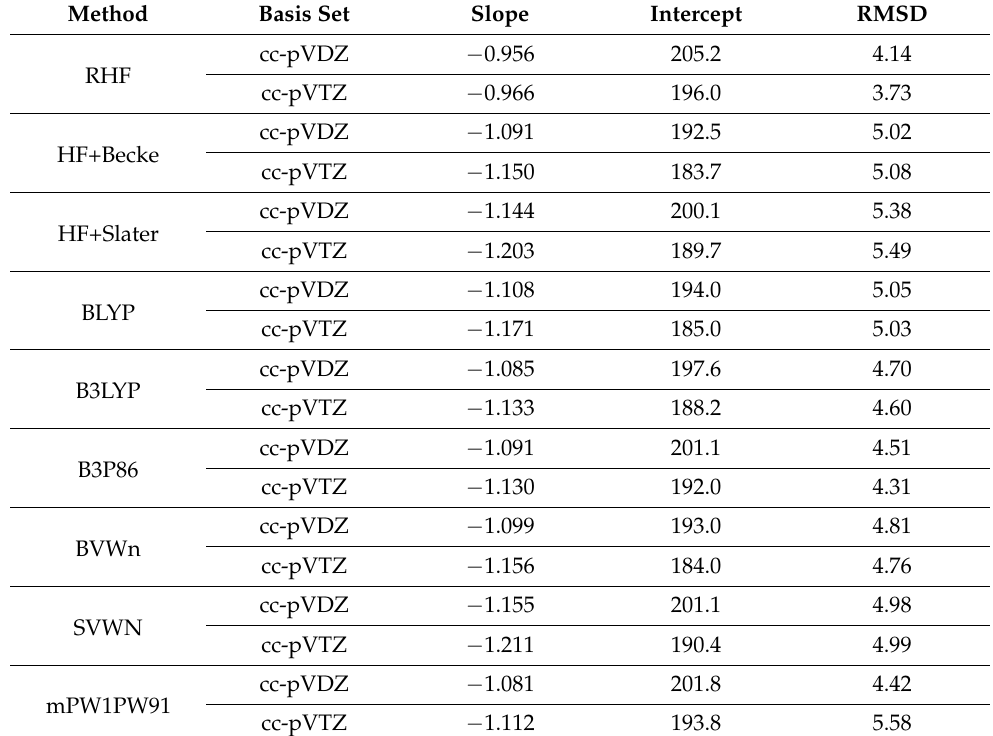
Table 6. Statistical parameters of the least-squares correlation of 13 C-NMR chemical shift tensors of 65 saccharides calculated with using different functionals and basis sets versus experiment. Compiled from Sefzik [151]. Method Basis Set Slope Intercept RMSD RHF